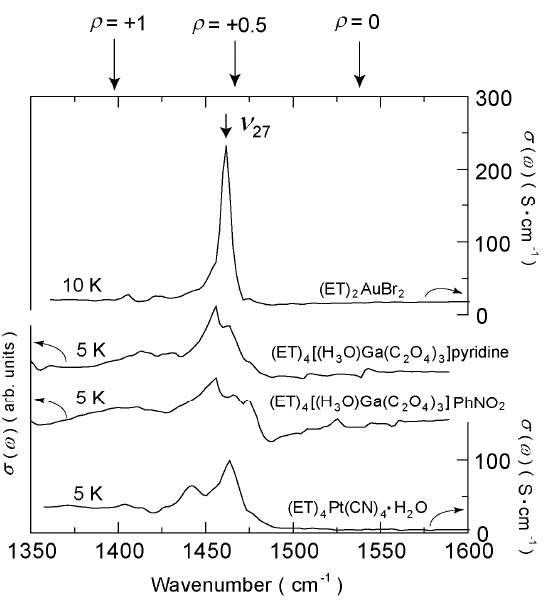
Figure 14. The ν ρ = 0, +0.5 and +1 are